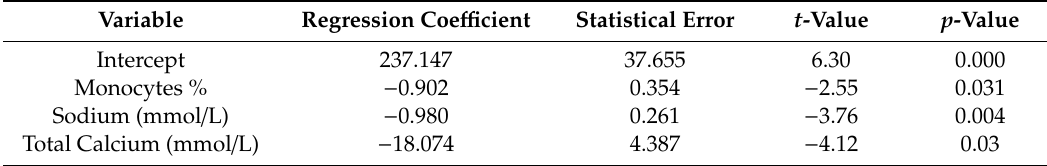
Table 5. Multivariate linear regression model parameters for r VO2 max, R 2 = 0.879.